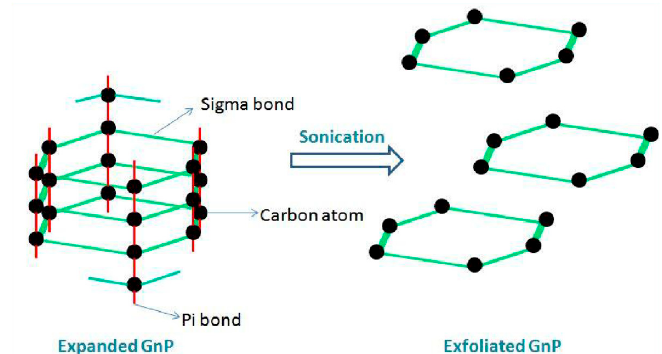
Figure 7. Mechanism of graphene dispersant after ultrasonication from expanded GNP to exfoliated